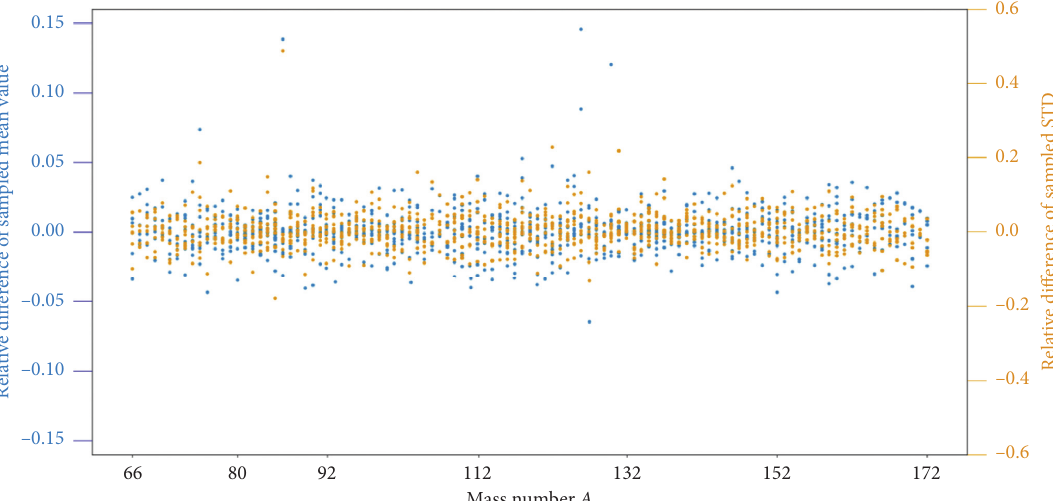
Figure 12: Relative difference of lognormal-based sampled independent fission yields mean values (blue dots) and STD (orange dots) to Bayesian updated values. The outlier fission products are (mean values) Ag130m0, Sn127m1, Cd126m0, In126m0, In118m1, Br86m1, and Ge75m0 and (STD values) Sb131m0, Ag130m0, Cd126m0, Sn122m0, and Br86m1.